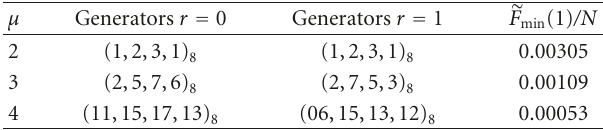
Table 3: Optimum overlays for rate 1 / (2 R ) COP-STC with QPSK, n = 2, m = 1, R = 1 in quasistatic channel. The basic code for a single transmitter is STC as in [27].